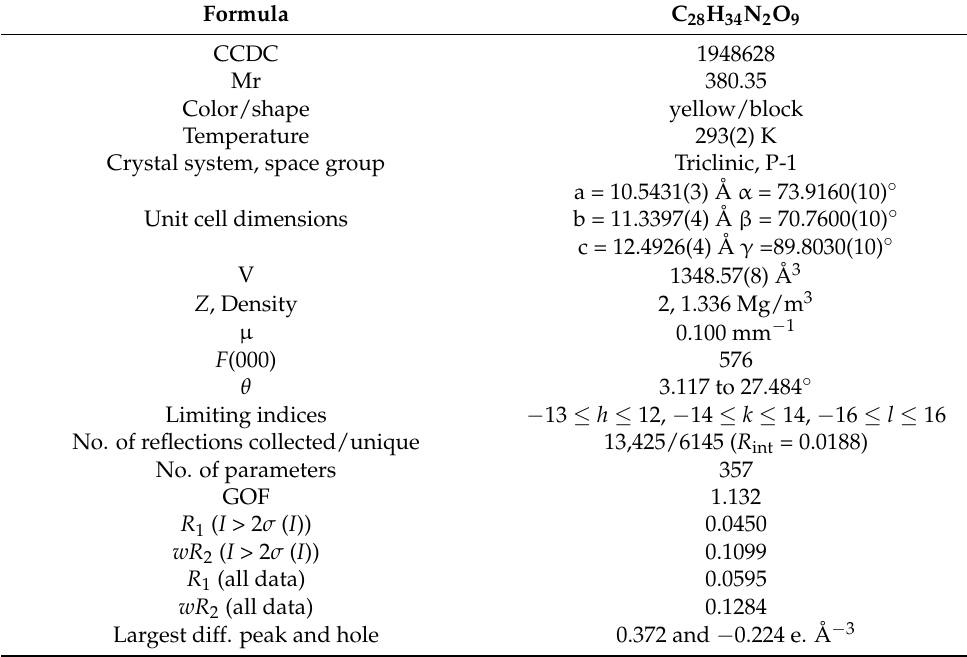
Figure 1. ( a ) ORTEP drawings of DBH ; ( b ) optimized geometric structure of DBH . Table 1. Crystal Data and Structure Refinement for DBH.